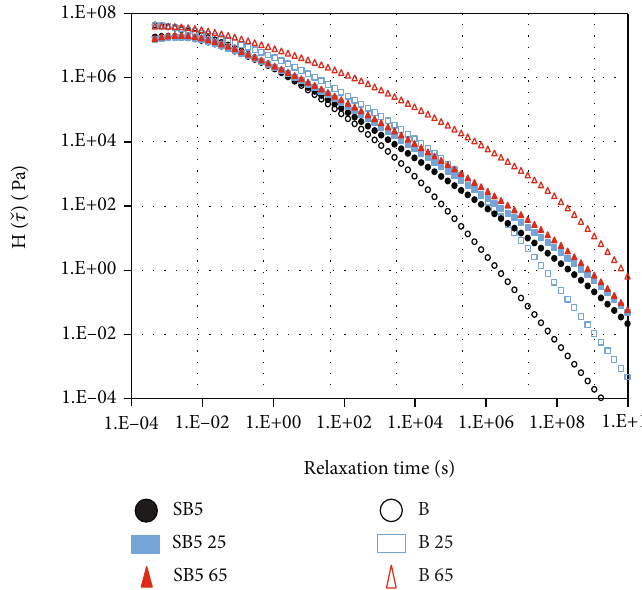
Figure 11: Relaxation spectra for the two binders at di ff erent levels of